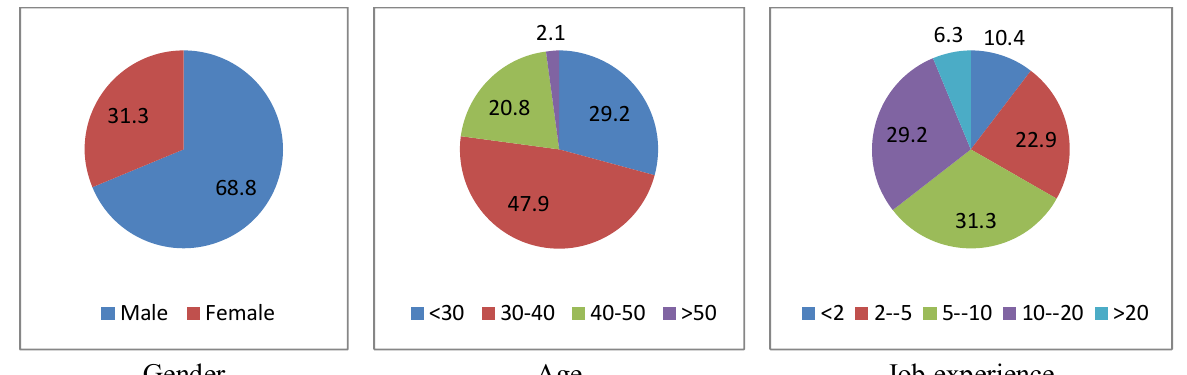
Fig. 2. Personal characteristics of the